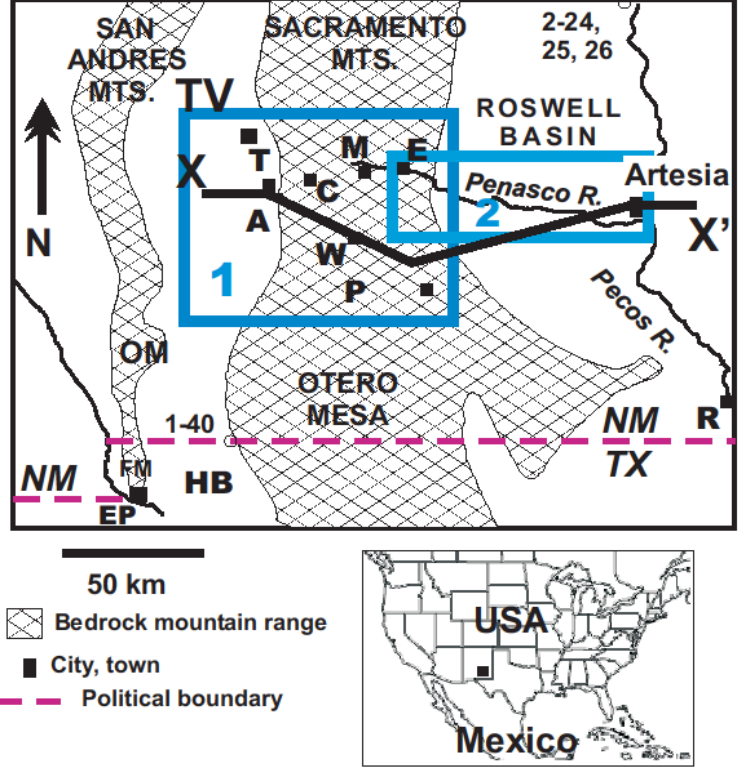
Figure 1. Map showing the study areas. Abbreviations are: NM = New Mexico; TX = Texas; A = Alamogordo; C = Cloudcroft; E = Elk; EP = El Paso; FM = Franklin Mountains; HB = Hueco Bolson; M = Mayhill; OM = Organ Mountains; P = Piñon; R = Red Bluff; T = Tularosa; TV = Tularosa Valley; W = Weed. X-X’ is the line of the geological section in Figure